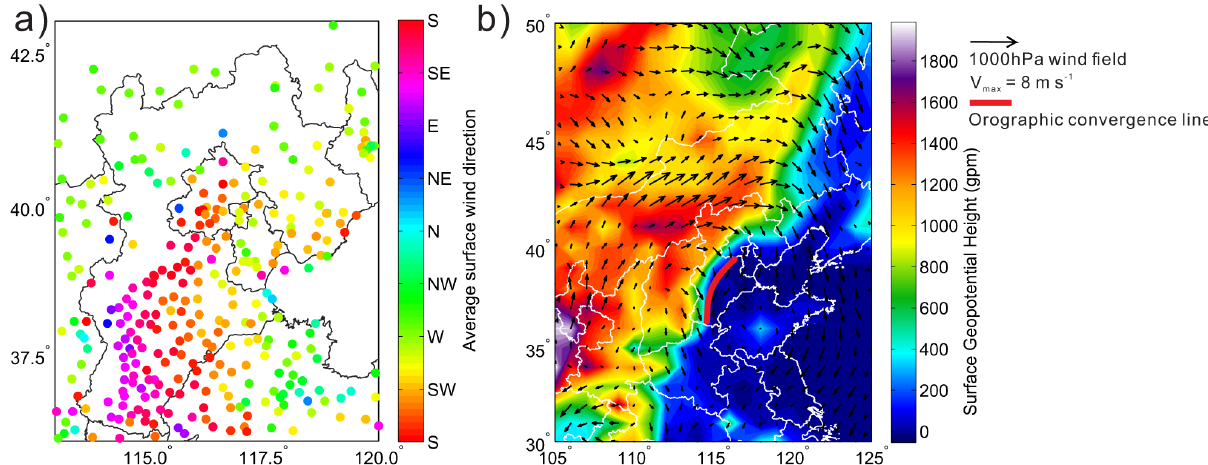
Figure 5. (a) Averaged 14h surface wind direction during May–December 2009 given by 307 AWS stations. (b) The orographic geopotential height above sea level (shading), the average 8h 1000hPa NCEP final analysis wind field (black arrows) and the orographically generated wind convergence line (red line) of 58 fog days during January 2009–February 2010.